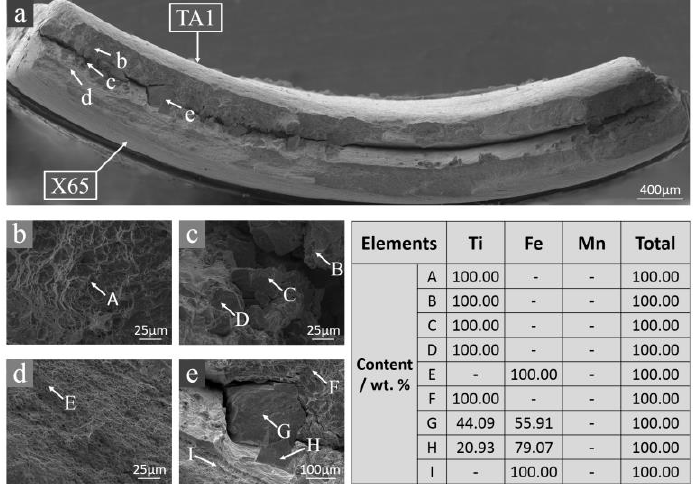
Figure 9. Morphologies and element distribution of the tensile fracture when the tensile direction was parallel to the direction of detonation wave propagation: ( a ) fracture morphology; and ( b – e ) b–e zone of a.